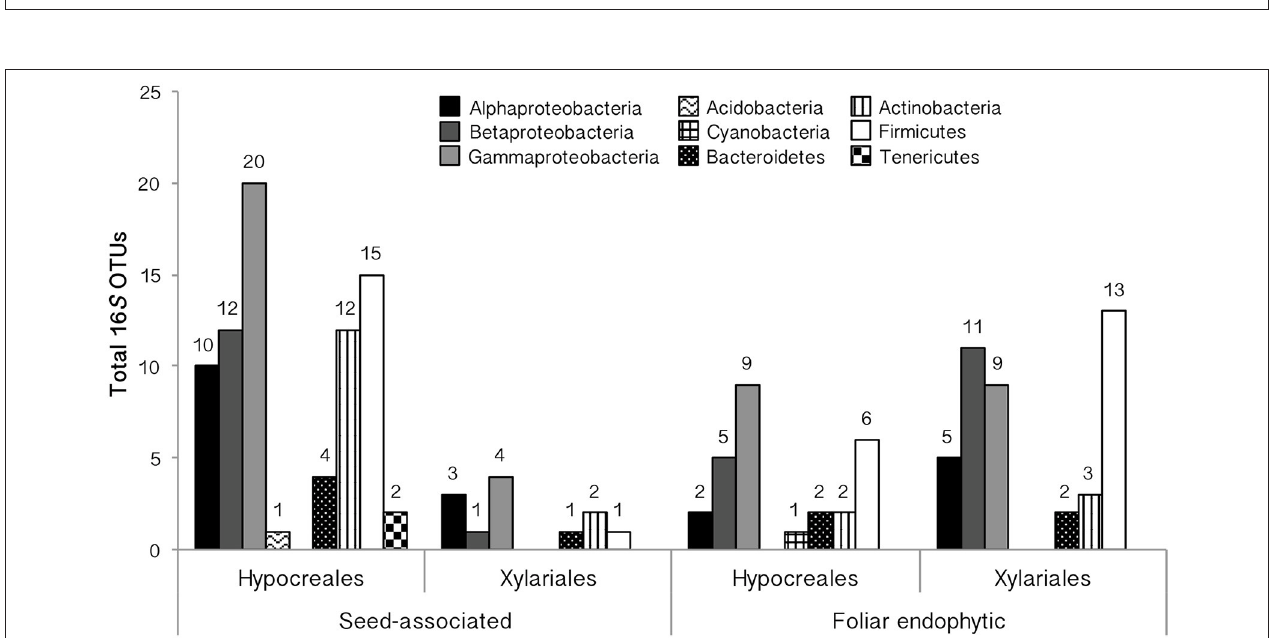
FIGURE 3 | Results of screening for EHB among tropical seed-associated and foliar endophytic Hypocreales and Xylariales. Frequency (% of positive samples) indicates the number of fungal isolates observed to have EHB out of the total number screened. Diversity is calculated as Fisher’s α . Richness indicates the number of EHB OTUs (97% 16 S similarity). Samples sizes for each group are shown.